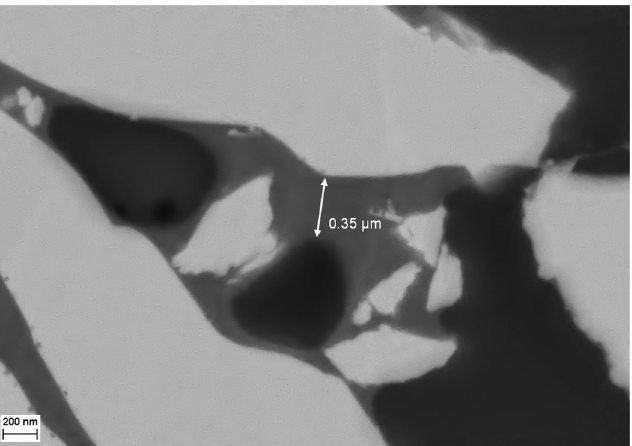
Figure 4. SEM cross section (magnification 30 k) of carbon coated CLM00007 (2.3 wt. % carbon) embedded in epoxy resin (Si: light gray region, C-coating: dark gray region, epoxy resin: black region). In the image, areas with very thick C-layers and Si particles sharing a C-layer are visible, which illustrates the formation of aggregates. This effect is also observed as an increase in the percentile values of the PSD (see Table 2). Thin C-layers (<20 nm) on the silicon surface are not visible in the present magnification.